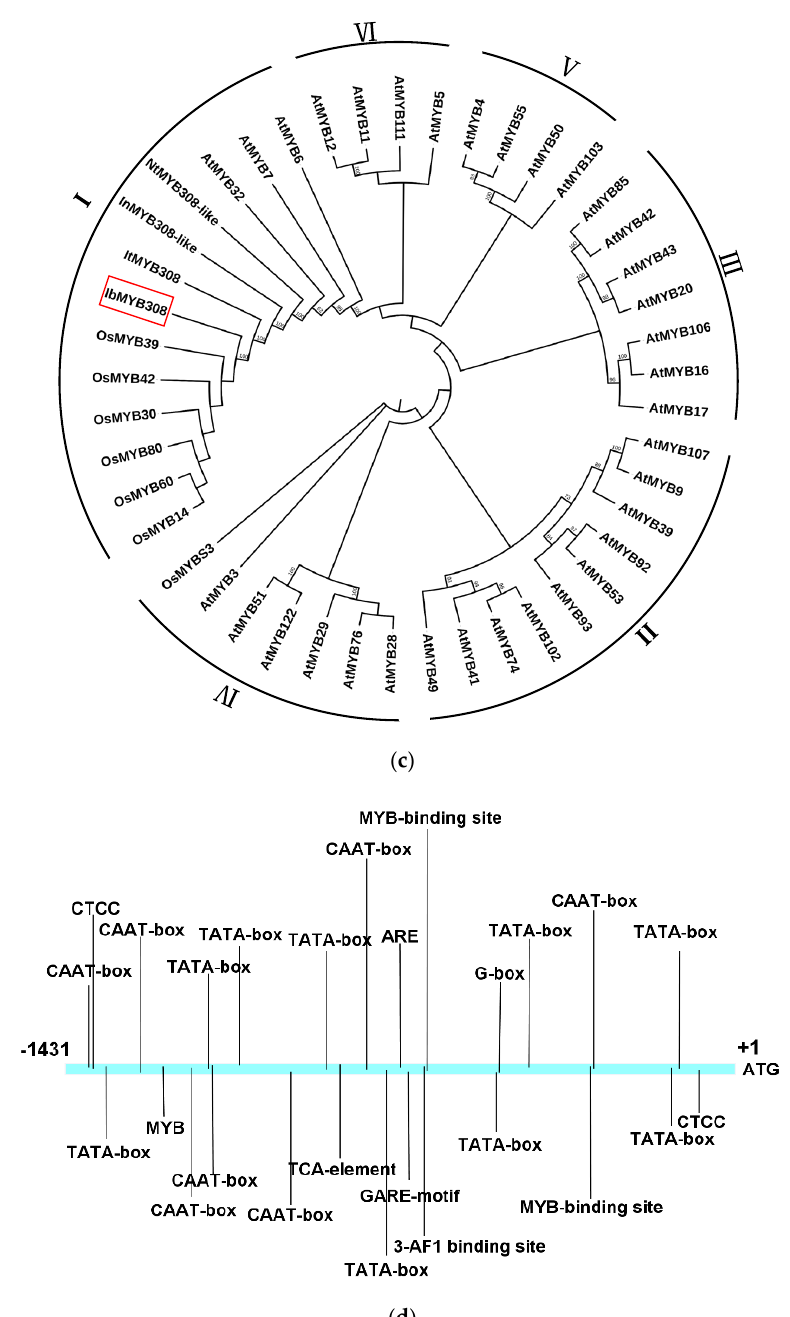
Figure 1. Characterization of IbMYB308 . ( a ) Genomic structures of IbMYB308 . Boxes indicate exons, and lines indicate introns. ( b ) Multiple protein sequence of IbMYB308 with R2R3-MYB DNA binding domains in Olea europaea (accession number CAA2964916.1), Pistacia vera (XP_031265728.1), Mangifera indica (XP_044488236.1), Gossypium hirsutum (XP_016708004.1), Nicotiana tabacum (NP_001311732.1), Prunus persica (XP_007200603.1), Solanum pennellii (XP_015066308.1), Jatropha curcas (XP_012081759.1), Juglans regia (XP_018823839.1), Hibiscus syriacus (XP_039065864.1), and Eucalyptus grandis (XP_039166990.1). The identical and similar amino acids are shaded in black, pink, and light blue, and conserved domains are marked by black lines. ( c ) Phylogenetic analysis of IbMYB308. MEGA X software with the neighbor-joining (NJ) method (1000 bootstrap repeats) was used to construct the phylogenetic tree. IbMYB308 is marked with a red box. ( d ) The cis -acting elements of the IbMYB308